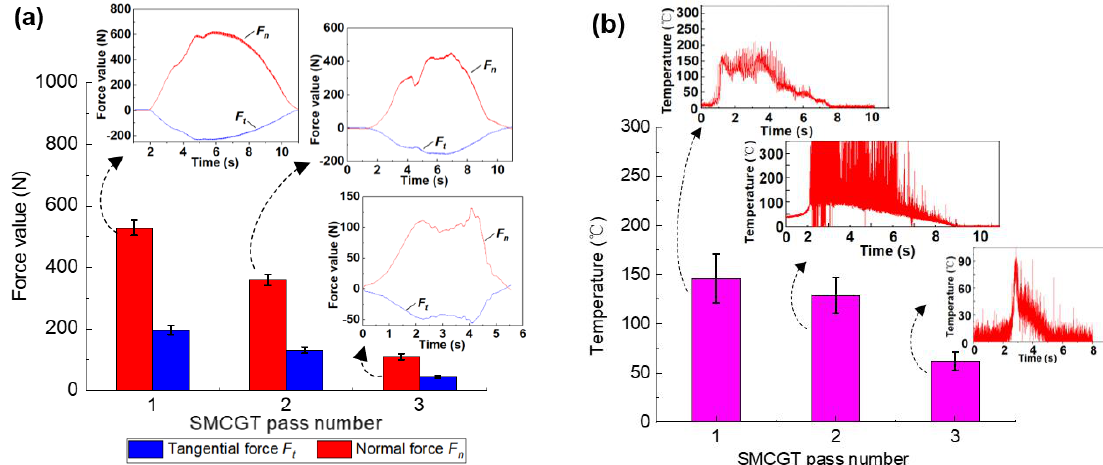
Figure 6. ( a ) The grinding forces and ( b ) grinding temperatures during SMCGT